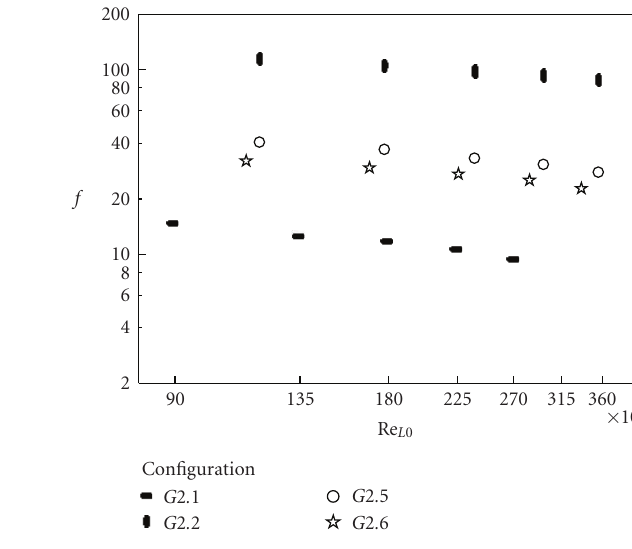
Figure 14: Pressure